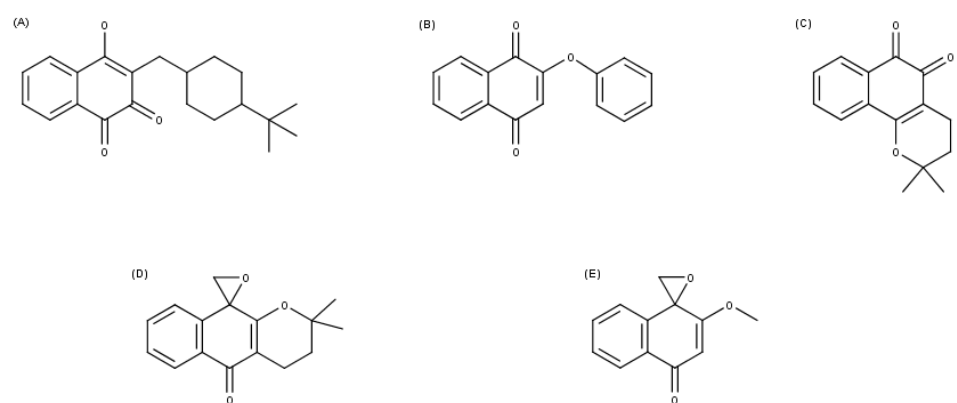
Figure 1. Structural formulas of naphthoquinone and its derivatives. ( A ) Buparvaquone (3-[(4-tert-butylcyclohexyl)methyl]-4-hydroxynaphthalene-1,2-dione); ( B ) B6 (2-phenoxy-1,4-naphthoquinone); ( C ) β -lapachone (2H-Naphtho[1,2-b]pyran-5,6-dione,3,4-dihydro-2,2-dimethyl); ( D ) Epoxy- α -lapachone (2,2-Dimethyl-3,4-dihydro-spiro[2H-naphtho[2,3-b]pyran-10, 2′ -oxirane]-5(10H)-one); and ( E ) Epoxymethyl-lawsone (2-Methyl-4H-spiro-[naphthalene-1,20-oxiran]-4-one).